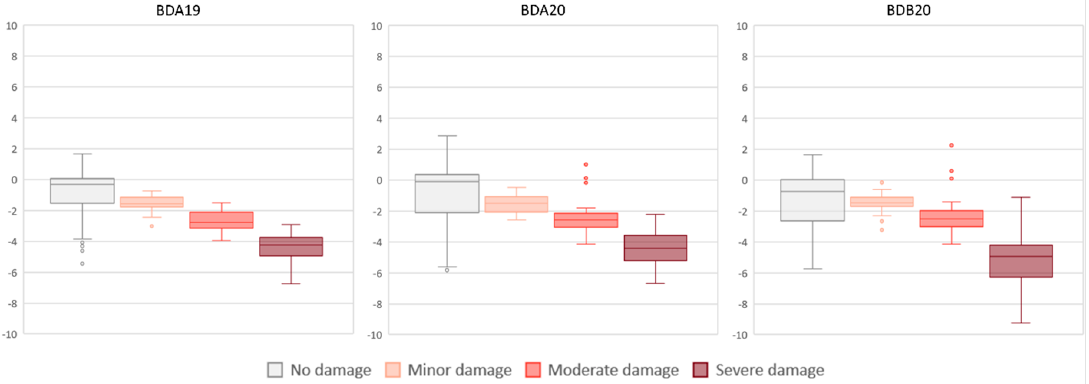
Figure 10. Box plots representing changes in vitality per ground truth class for each product.